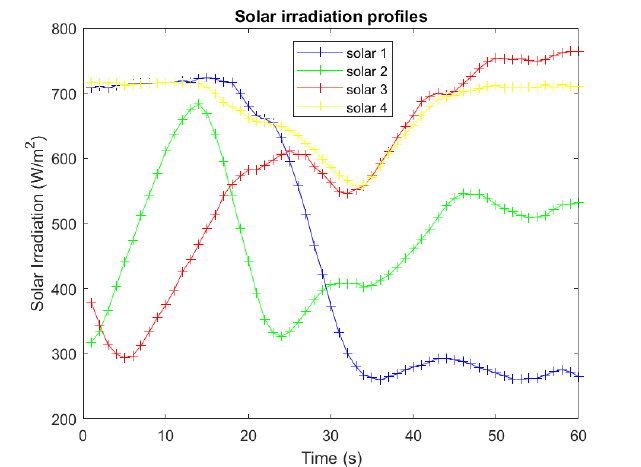
Figure 7. The CCN representation of the IEEE 34 bus system.